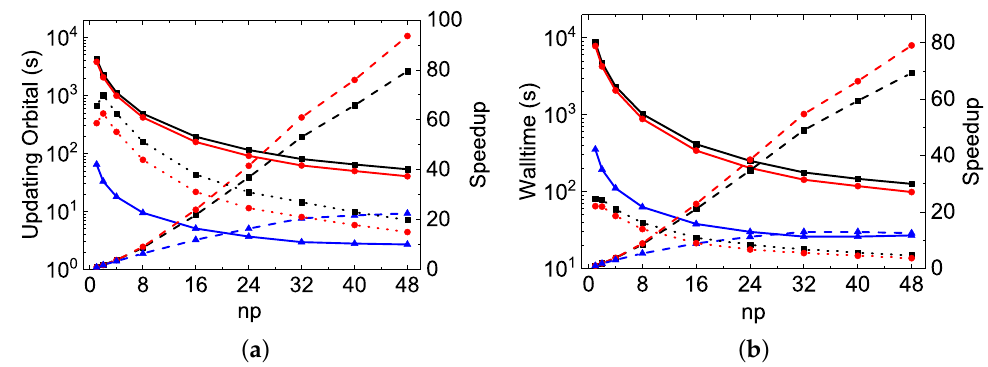
Figure 5. MPI performances for the Be I 9( spdf ghikl )-SCF calculations. ( a ) Solid (left y axis): orbital updating CPU times (T in s) for rmcdhf_mpi (squares), rmcdhf_mem_mpi (circles), and rmcdhf_mpi_FD (triangles) codes versus the number of MPI processes ( np ). Dashed line (right y axis): speed-up factors of the three codes (with the same corresponding symbols) estimated as the ratios of T ( np = 1 ) to others. Dotted line (right y axis): speed-up factors of rmcdhf_mpi_FD relative to rmcdhf_mpi (squares) and to rmcdhf_mem_mpi (circles), calculated as T ( rmcdhf_mpi )/ T ( rmcdhf_mpi_FD ) and T ( rmcdhf_mem_mpi )/ T ( rmcdhf_mpi_FD ), respectively. ( b ) Same as in ( a ), but for the walltimes.